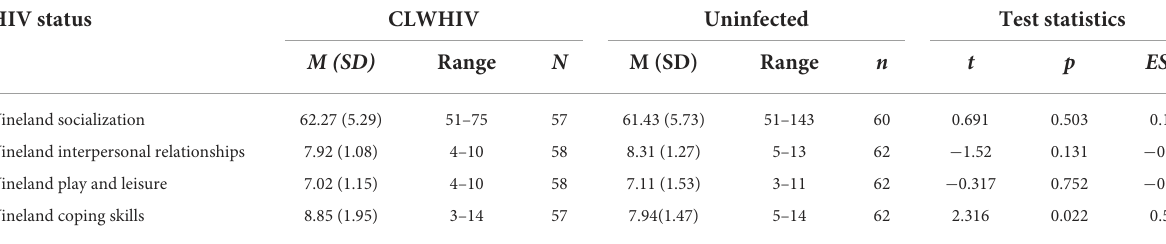
TABLE 5 Between group comparisons on the Vineland Adaptive Behavioral Scale: Socialization subscale a